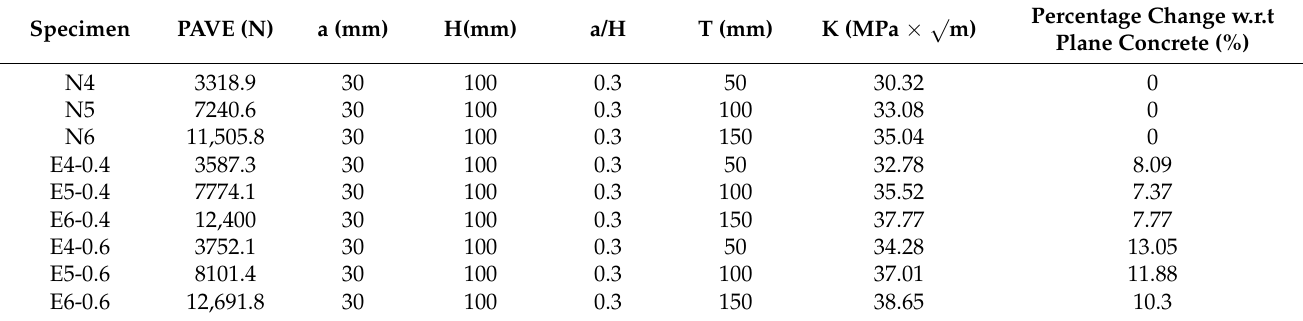
Table 8. Critical stress intensity factor for different widths T